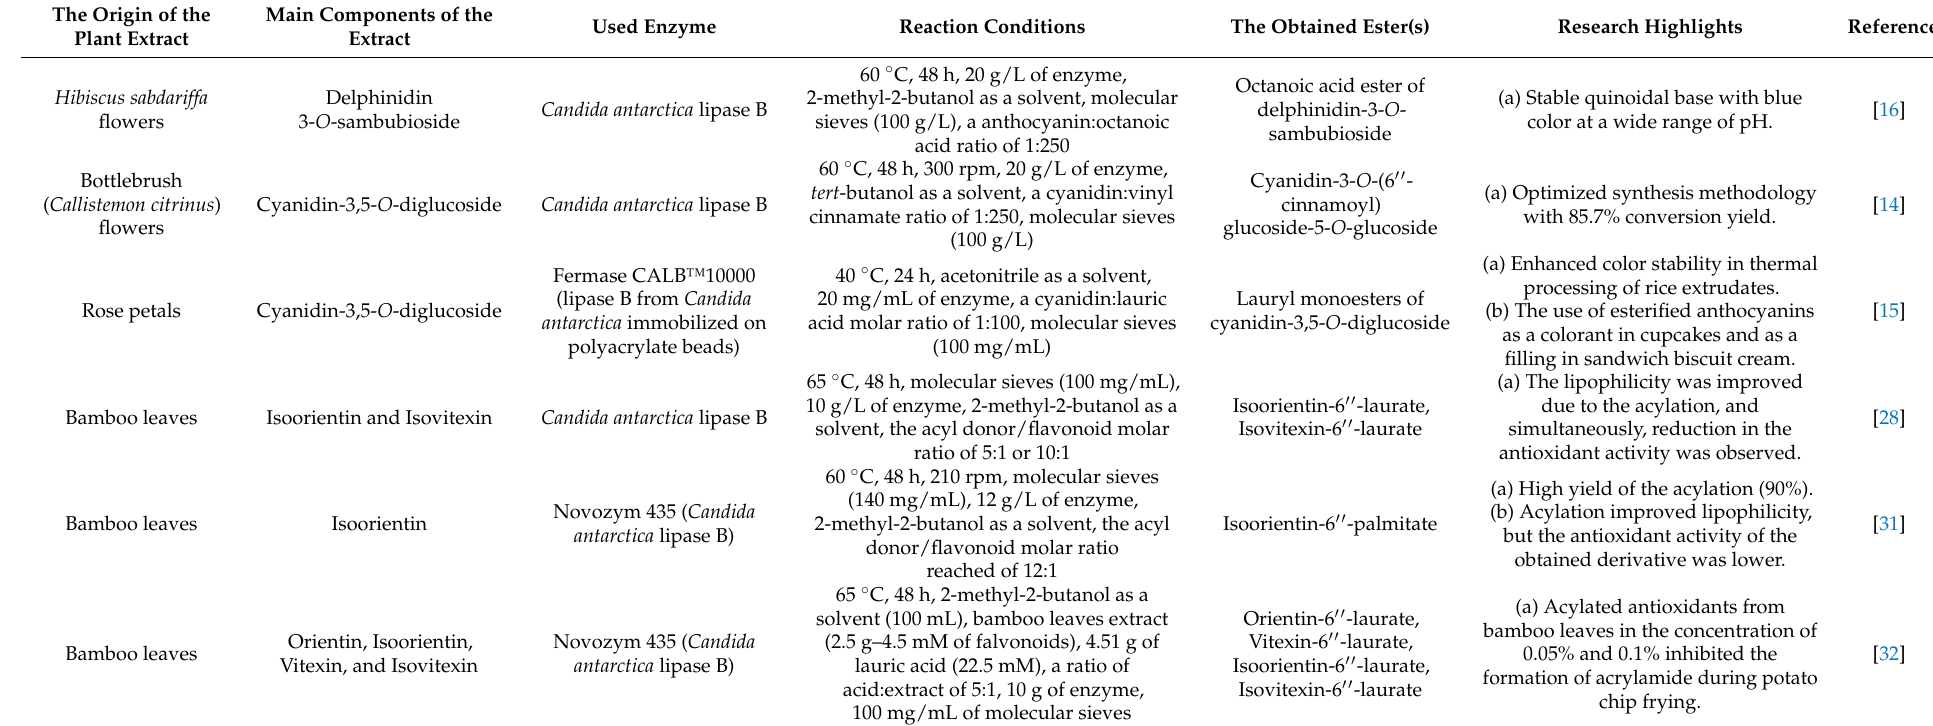
Table 2. Plant extracts from flowers and leaves used in enzymatic modifications of phenolic